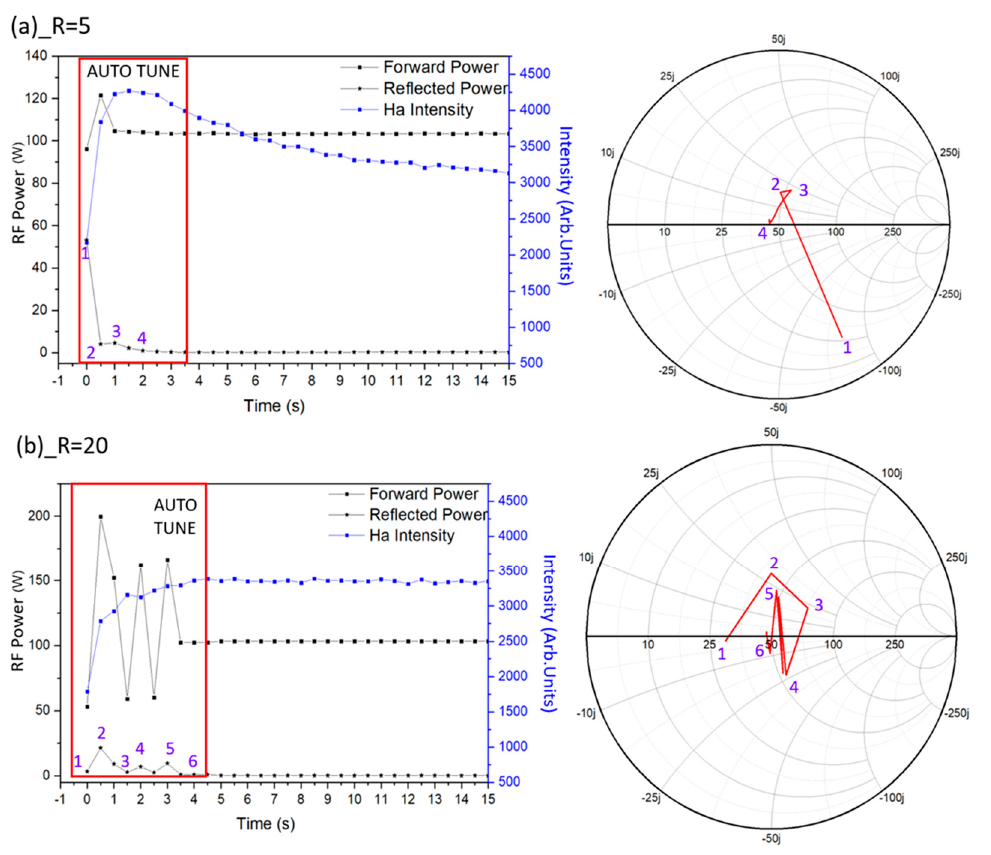
Figure 7. The auto-tune results of RF power supply on the RF-positive power source: ( a ) R = 5; and ( b ) R = 20. Forward and reflected waveform of coupled RF power source (left) and associated Smith chart (right).